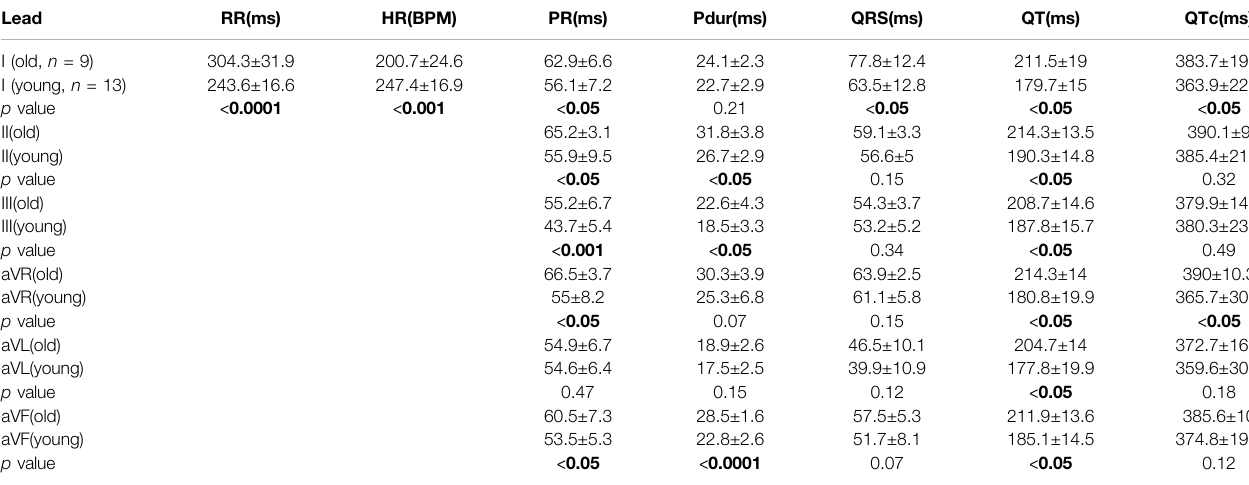
TABLE 6 | Age-dependent effects on ECG parameters from different leads, using NES-AN approach. Lead